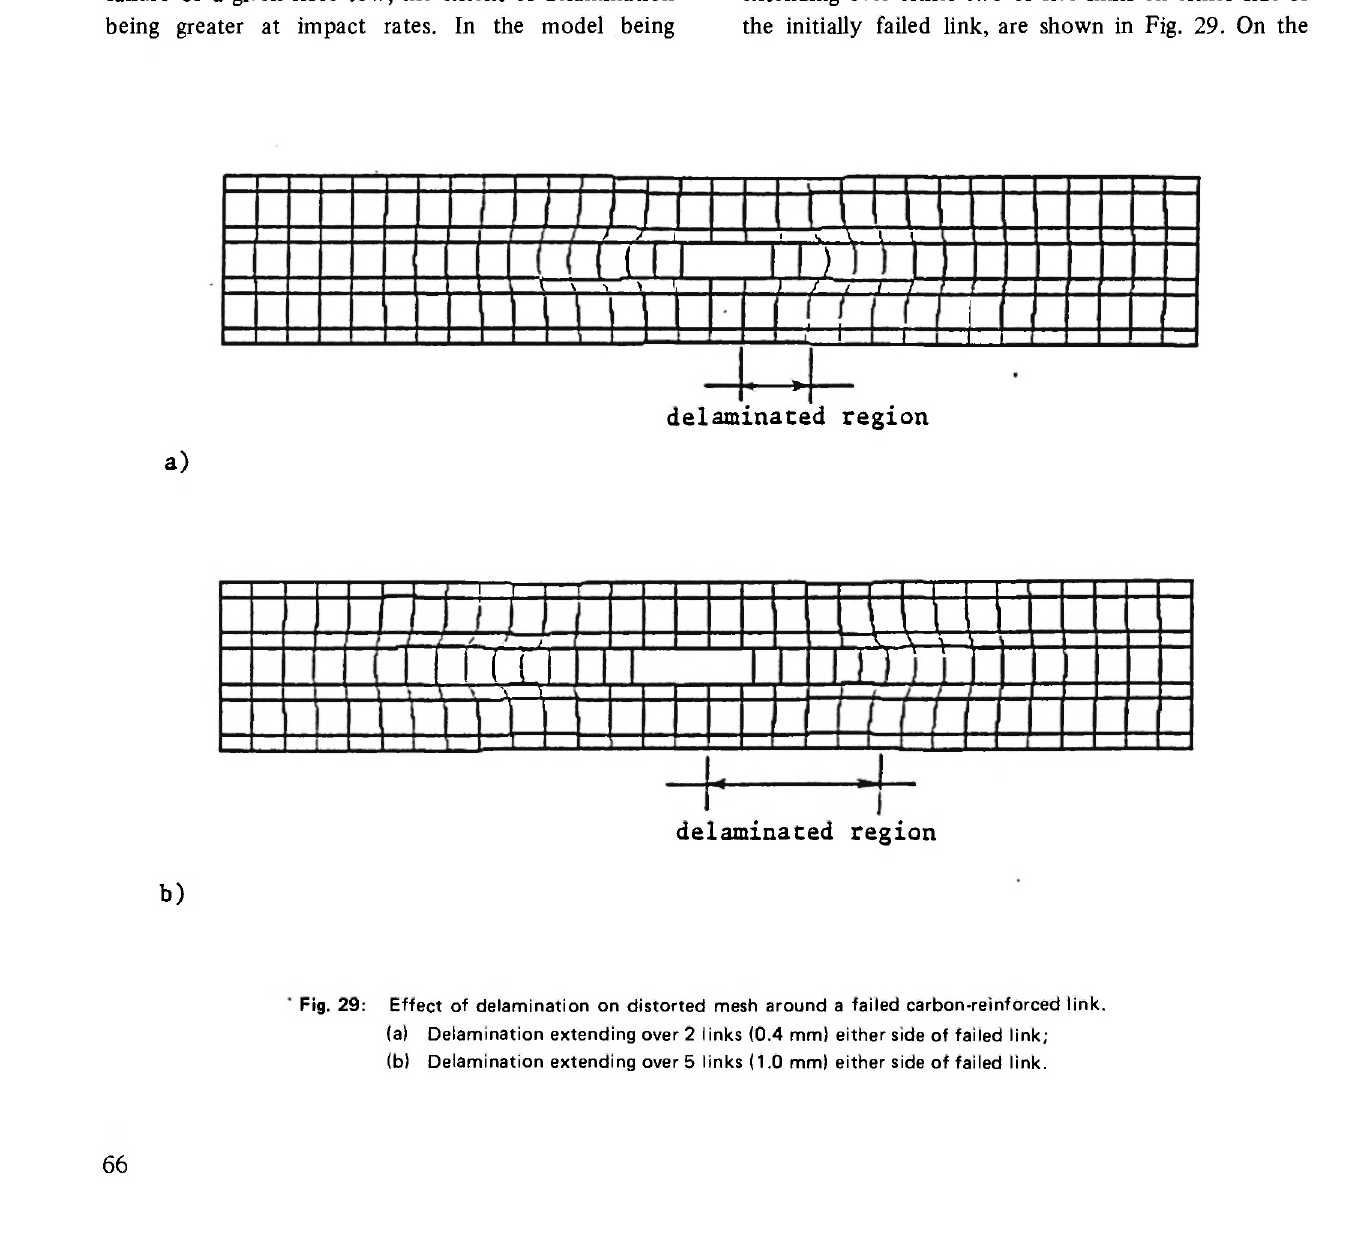
Fig. 29: Effect of delamination on distorted mesh around a failed carbon-reinforced link. (a) Delamination extending over 2 links (0.4 mm) either side of failed link; (b) Delamination extending over 5 links (1.0 mm) either side of failed